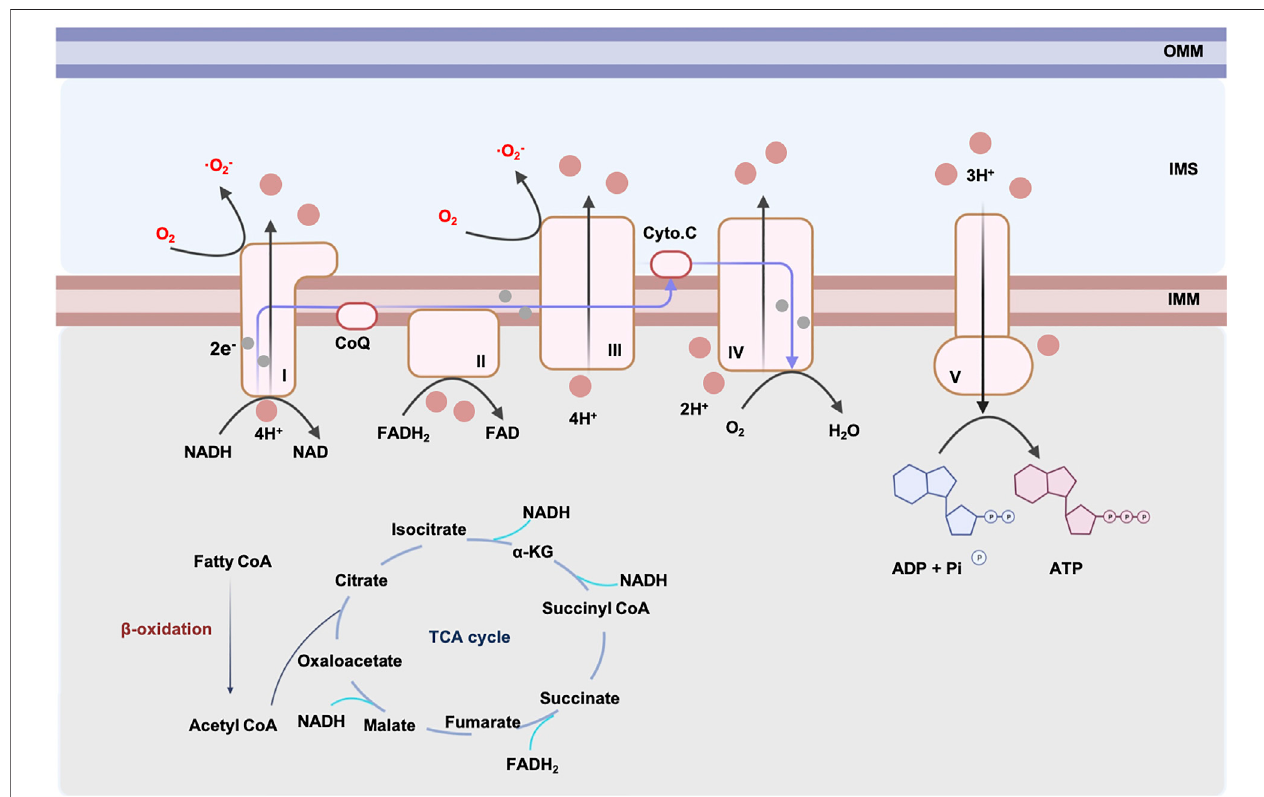
FIGURE 1 | ATP generation and ROS production in cardiac mitochondrion. The major resource of cardiac mitochondria comes from β -oxidation. Generation of NADH andFADH 2 from β -oxidation and TCA cycleareused byrespiratorychaincomplexes.Respiratory chain complexes arelocated inIMM. Electrons generatedfrom complex I, II pass through the respiratory chain and alter the concentration gradient of H + . Complex V produces ATP driven by H + fl ow. During the generation of ATP, complex I and III produce O 2 − . Excessive ROS leads to mitochondrial dysfunction. Abbreviations: IMM, inner mitochondrial membrane, OMM, outer mitochondrial membrane, IMS, mitochondrial intermembrane space, ROS, reactive oxygen species, NADH, reduced nicotinamide adenine dinucleotide, FADH2, reduced fl avin adenine dinucleotide, CoQ, coenzyme Q, Cyto. C, cytochrome C, ADP, adenosine diphosphate, ATP, adenosine-triphosphate triphosphate, TCA, tricarboxylic acid cycle, CoA, coenzyme A, α -KG, α